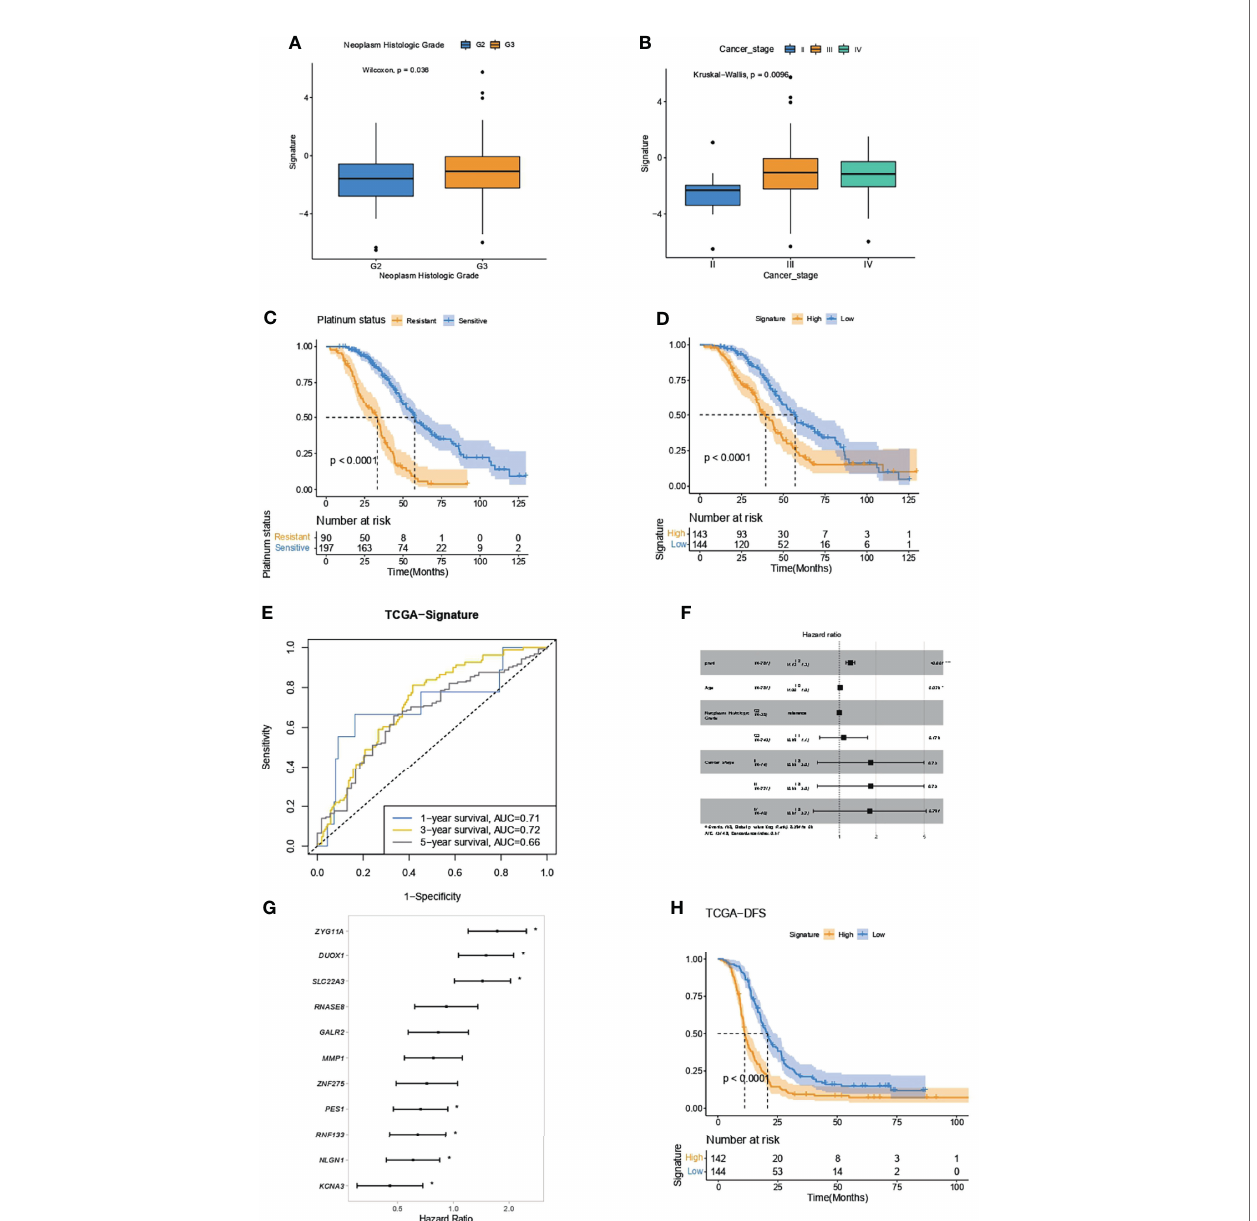
FIGURE 6 | IPR signature had the capacity in survival prediction in the training cohort. (A) The difference in IPR signature score between samples with G2 and G3 neoplasm histological grade. (B) The difference in IPR signature score between samples with different cancer stages; Kaplan – Meier analysis showed a signi fi cantly inferior overall survival in platinum-resistant ovarian cancer patients (C) and high-IPR signature patients (D) . (E) The ROC curve of the IPR signature in predicting the 1-, 3-, and 5-year survival in the training cohort. (F) Multivariate Cox regression analysis identi fi ed that the IPR signature and age were the two independent variable for the overall survival. (G) Forest plot of the hazard ratio for the association of each gene related to IPR signature score with overall survival. (H) Kaplan – Meier analysis of the disease-free survival (DFS) of patients with different IPR signature score. * p <